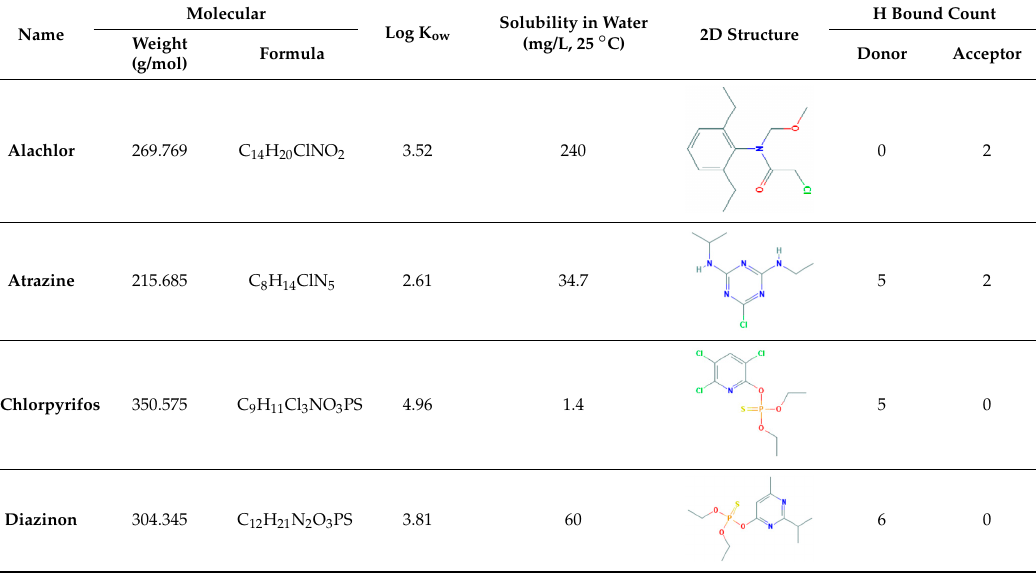
Table 1. Characteristics of Alachlor, Atrazine, Chlorpyrifos and Diazinon [26].